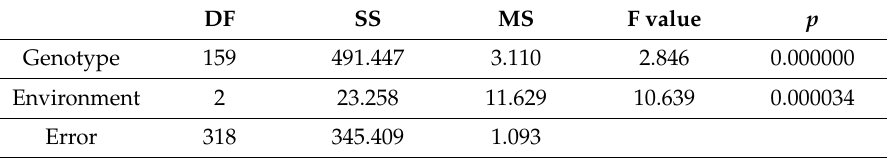
Table 1. Analysis of variance of stem rust resistance in spring wheat genotypes.